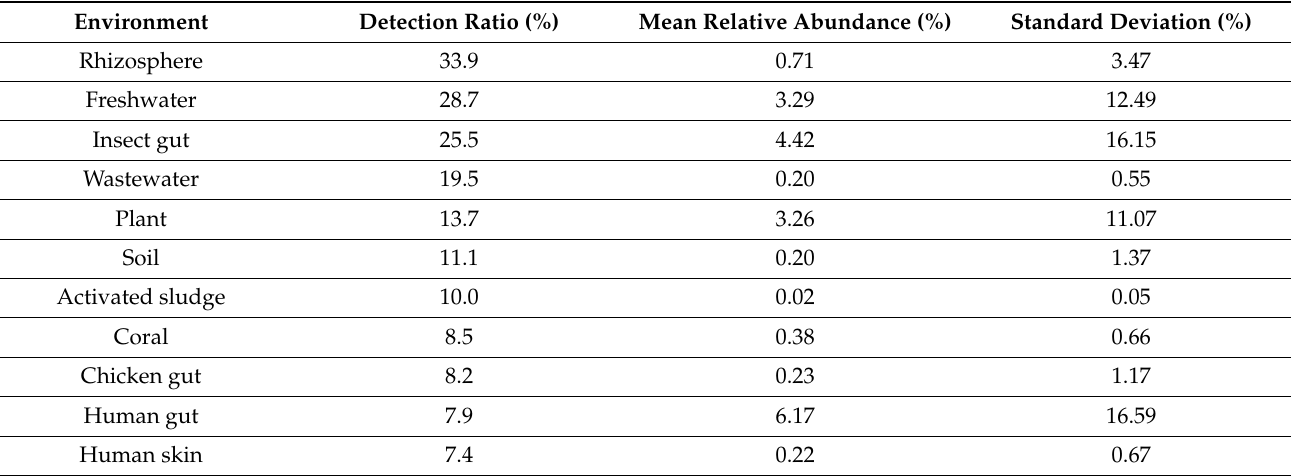
Figure 3. Habitat distribution and preference analysis comparing the 16S rRNA gene sequence of strain V-78 with a database of 16S rRNA gene amplicons obtained from 19 different environments by the Protologger. Table 3. Habitat preference and distribution analysis of strain V-78 based on the 16S rRNA gene amplicons obtained from the IMNGS database by the Protologger software.